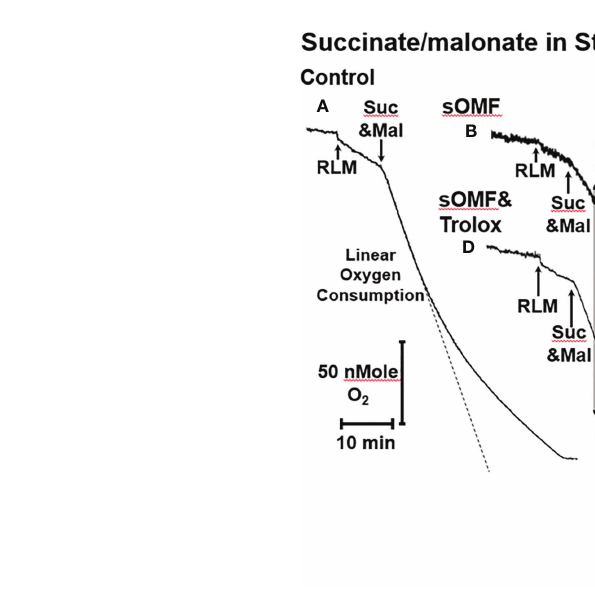
an anti-slip rotating turn table. The turn table was mounted on anti-vibration rubber pads.